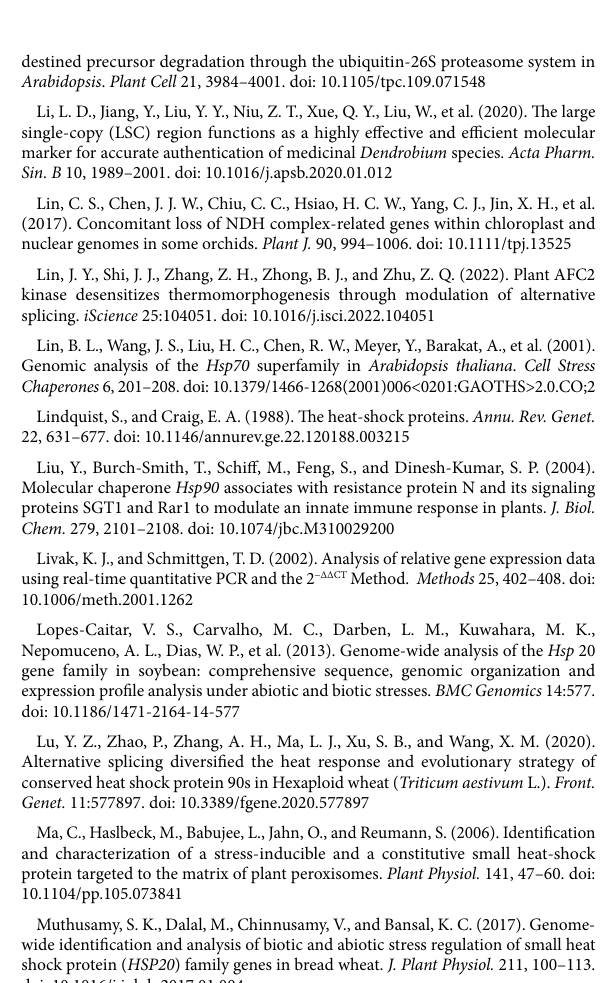
SUPPLEMENTARY FIGURE 3 Cis -acting elements in the promoter regions of Hsp20 , Hsp70 and Hsp90 genes in D. officinale and statistical summary. (A) Cis -elements with